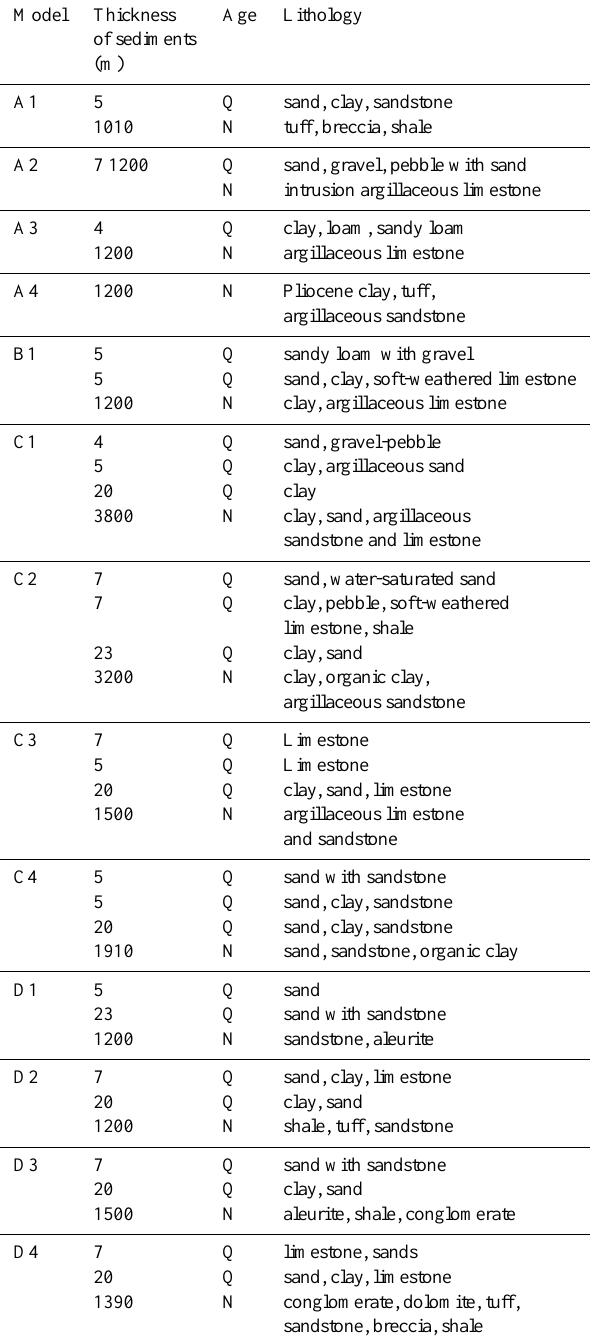
Table 2. Subsurface models for the Baku